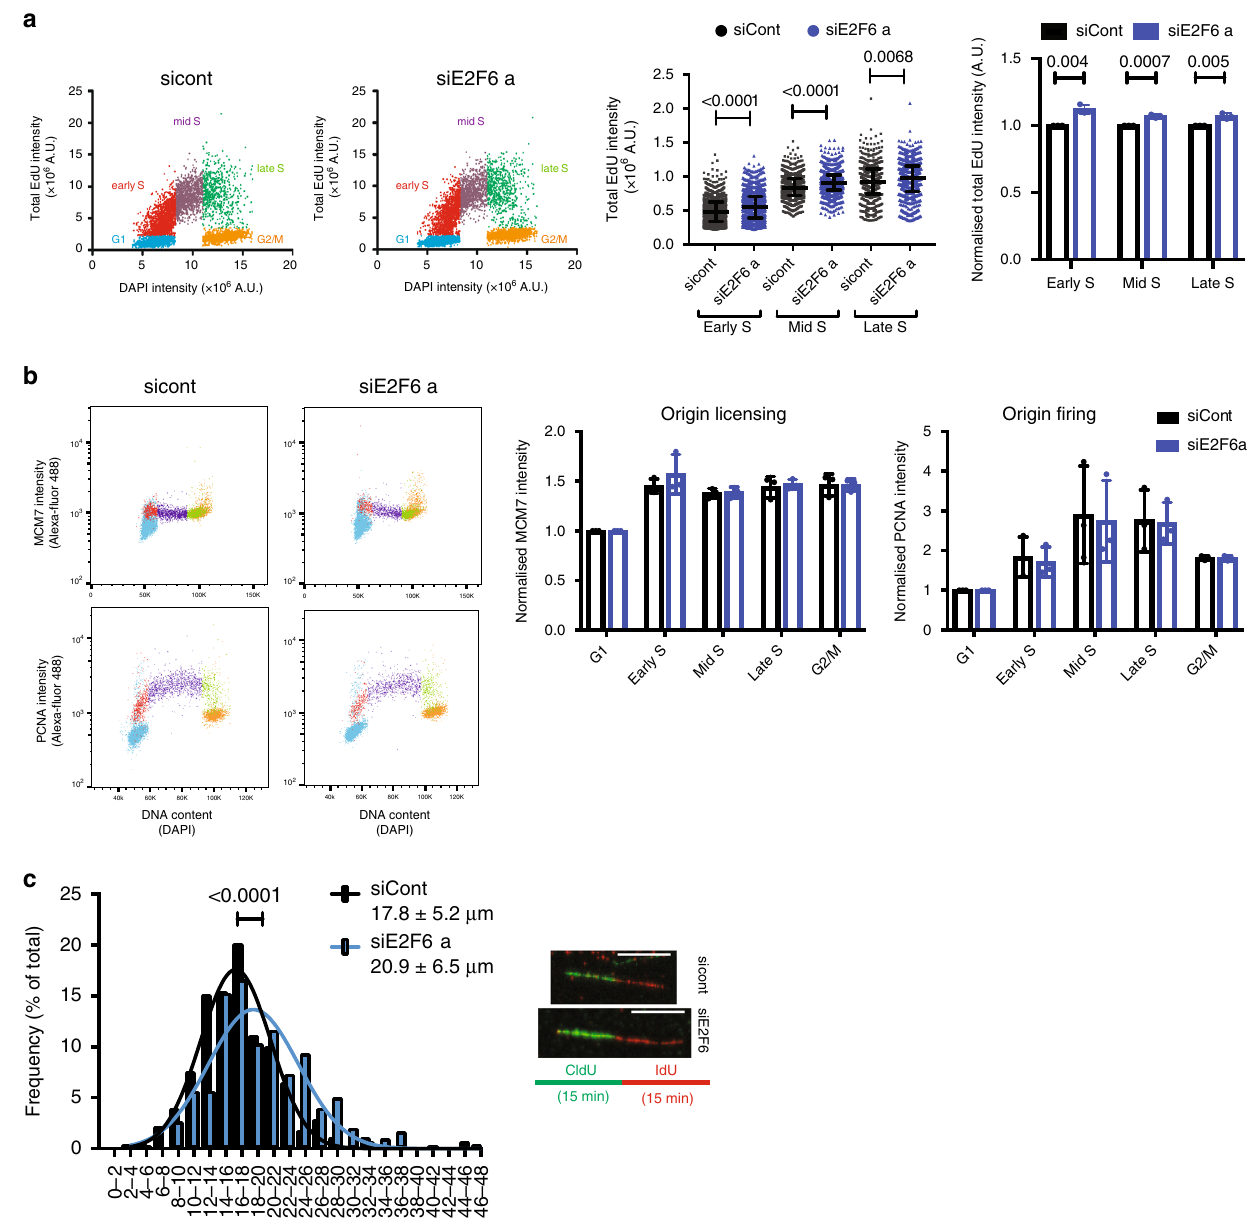
Fig. 2 Maintained E2F-dependent transcription in S phase increases the replication capacity of cells. a Asynchronous RPE1 cells were reverse transfected and 24 h later pulsed with EdU for 30 min before fi xation and immuno fl uorescence staining. Left, cell population was divided into fi ve groups based on DNA stain and EdU incorporation, as indicated on the coloured scatter plots. G1: EdU negative and G1 DNA content, Early S: EdU positive and G1 DNA content, Mid S: EdU positive and intermediate DNA content, Late S: EdU positive and G2 DNA content. Signi fi cance was determined by Mann – Whitney, mean and S.D. of representative experiment of three biological repeats are shown. Right, total EdU intensity from n = 3 experiments normalised to siCont value at each part of S phase, signi fi cance determined by student ’ s t -test. b RPE1 cells were pulse labelled with EdU for 30 min 24 h following transfection and fl ow cytometry used to quantify PCNA and MCM7 content on chromatin, fl ow cytometry plots shown from one of n = 3 experiments, values are normalised to G1, mean and S.D. are shown. Cell population was divided based on DAPI (DNA content) and EdU staining as in ( a ). Signi fi cance determined by 2-way ANOVA with Dunnett's multiple comparisons test. c RPE1 cells were analysed by DNA fi bre analysis 24 h following transfection with the indicated siRNA. Mean and S.D. of fi bre lengths shown from n = 3 experiments, Mann – Whitney test used to determine signi fi cance, at least 150 fi bres were counted per condition. Scale bar represents 10 μ